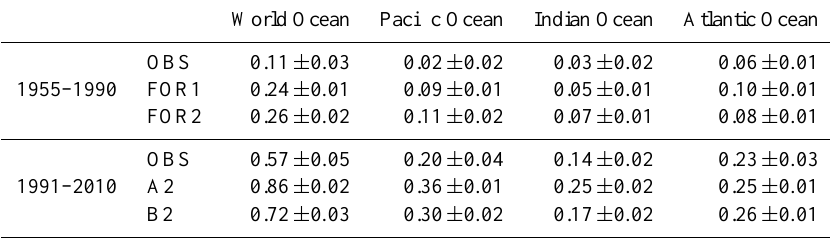
Table 2. Linear trends in OHC700 (in 10 22 Jyr − 1 ) during the periods 1955–1990 and 1991–2010 in the world ocean, and the three main basins. Uncertainties inherent to the least square regression method used to compute the trends are also